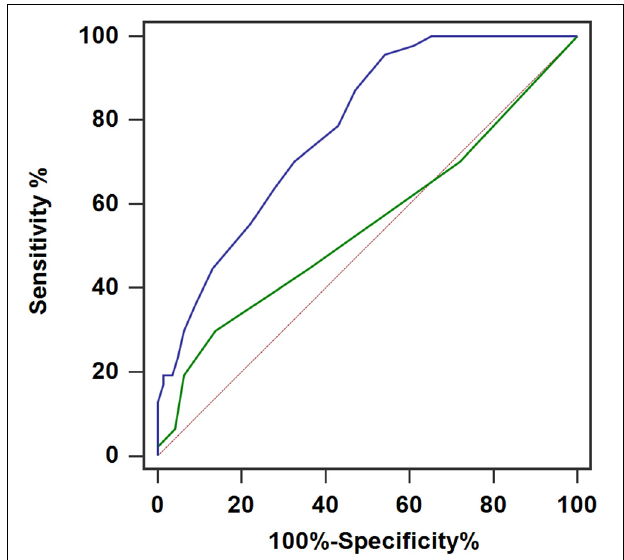
TABLE 1 | Clinical characteristics of the study population.